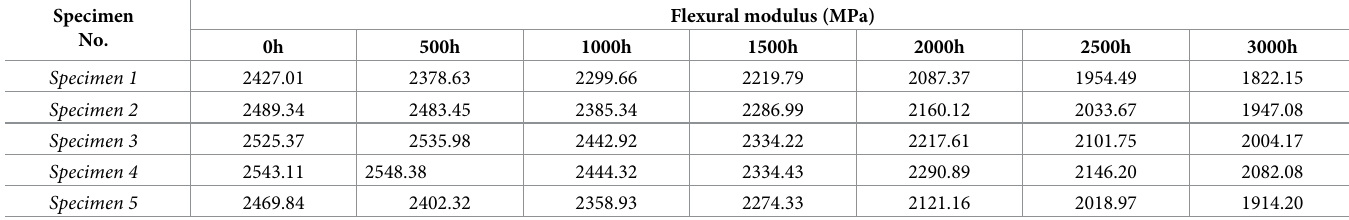
Table 5. Flexural moduli before and after UV-accelerated aging. Specimen